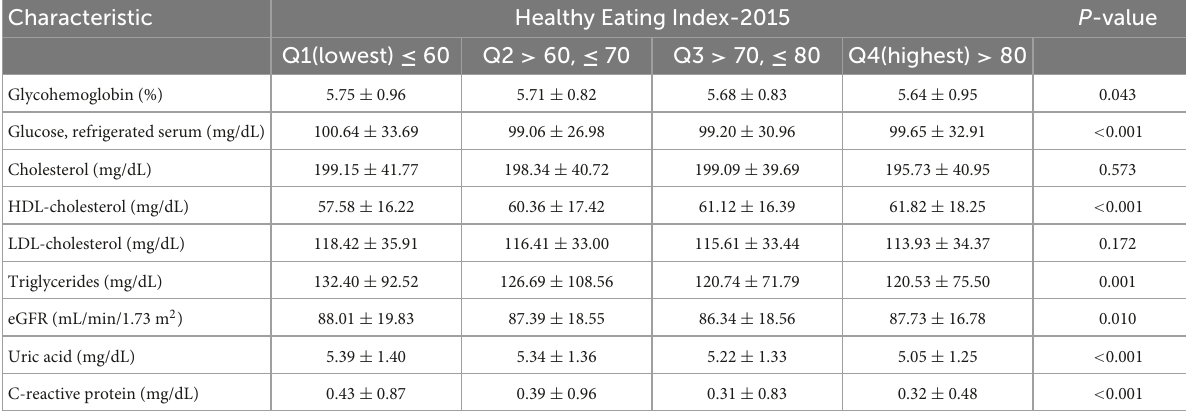
TABLE 2 Baseline levels of cardiometabolic markers according to participants.